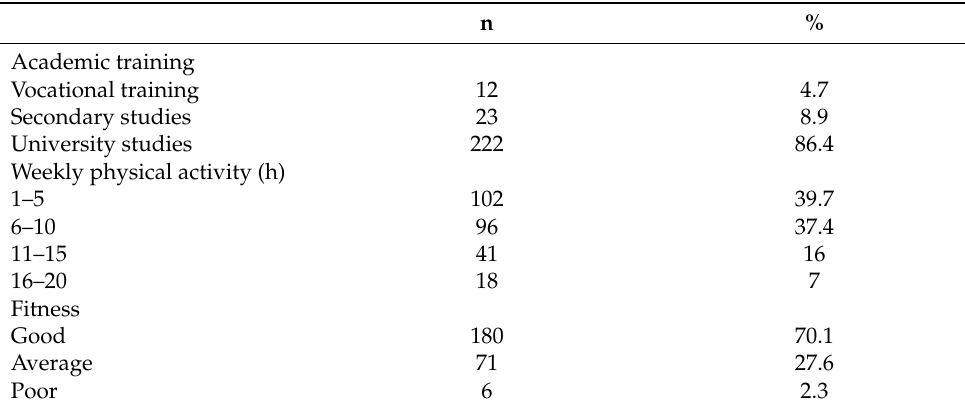
Table 1. Descriptive characteristics of the study